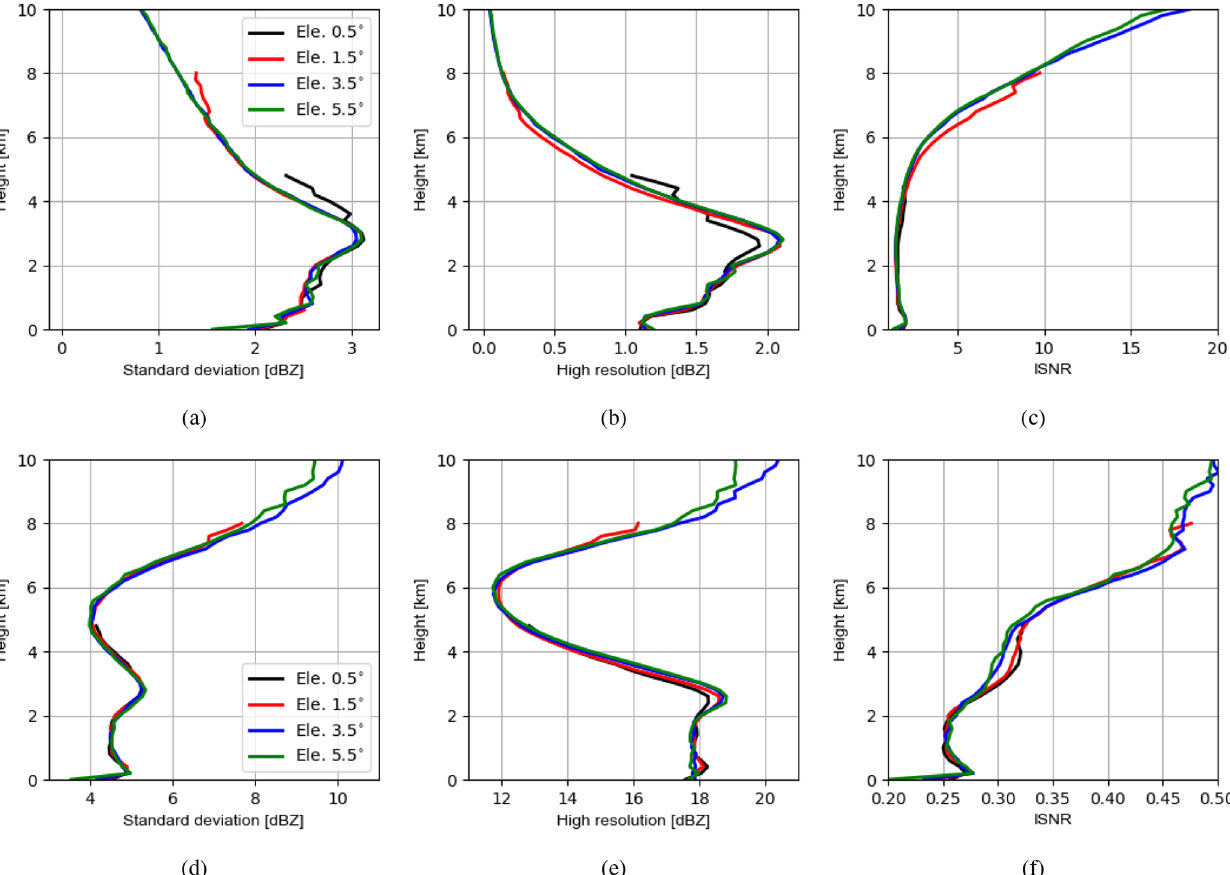
Figure 4. (a) Vertical profiles of the estimated standard deviations of the RE for reflectivity data ≥ 0dBZ at elevations of 0 . 5, 1 . 5, 3 . 5 and 5 . 5 ◦ . (b) Vertical profiles of simulated reflectivity data ≥ 0dBZ in the high-resolution model run, averaged over all samples; (c) ISNR (inverse of signal-to-noise ratio), i.e., standard deviations in panel (a) are divided by high-resolution data in panel (b) for each elevation, respectively; (d–f) reflectivity data ≥ 5dBZ. For each elevation, the samples are binned every 200m in the vertical. Here, we show results only up to 10km to be consistent with Sect.